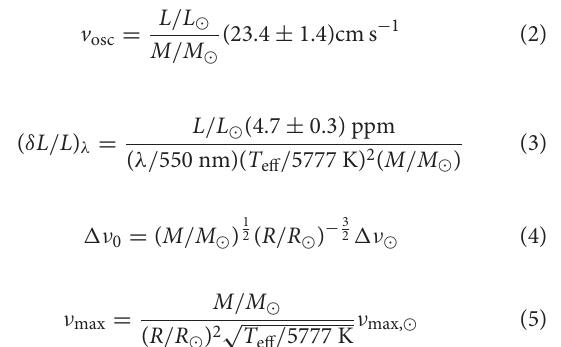
TABLE 1 | Overview of observed 1ν